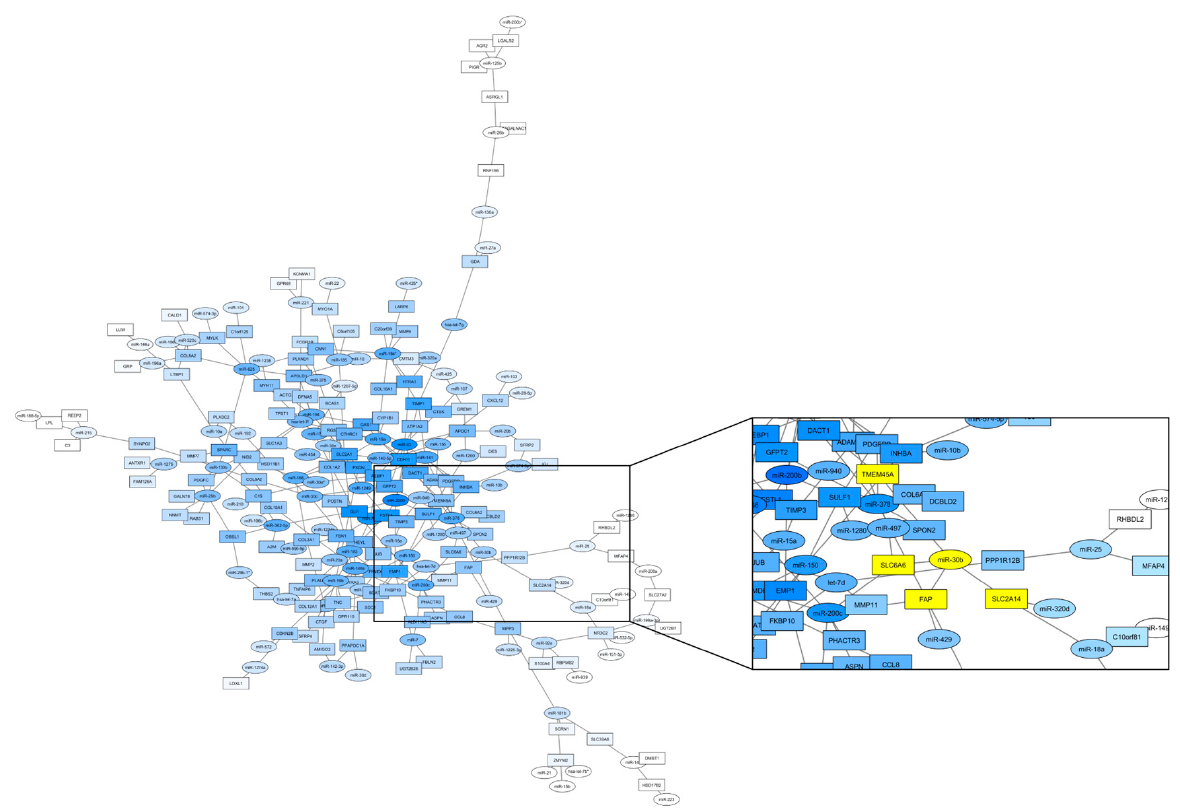
Figure 3. Regulatory Network of the High-Stroma/CMS4-miR-HS-subtype. Nodes reflect mRNAS (squares) and miRNAS (circles), while edges represent a predicted interaction between them. Grey intensity is mapped to each node’s closeness centrality value, the lighter nodes being the most marginal nodes. Square details the interactions between miR-30b and their first neighbors (those genes with a predicted interaction) represented as striped squares.